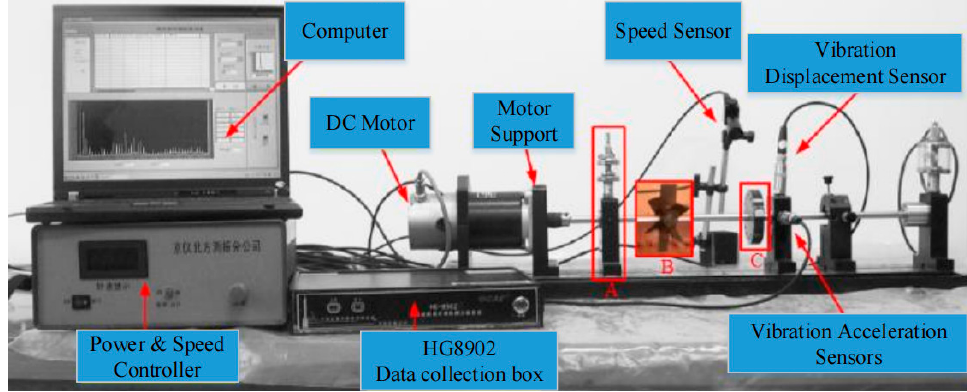
Figure 5. ZHS-2 type multifunctional motor test bench.